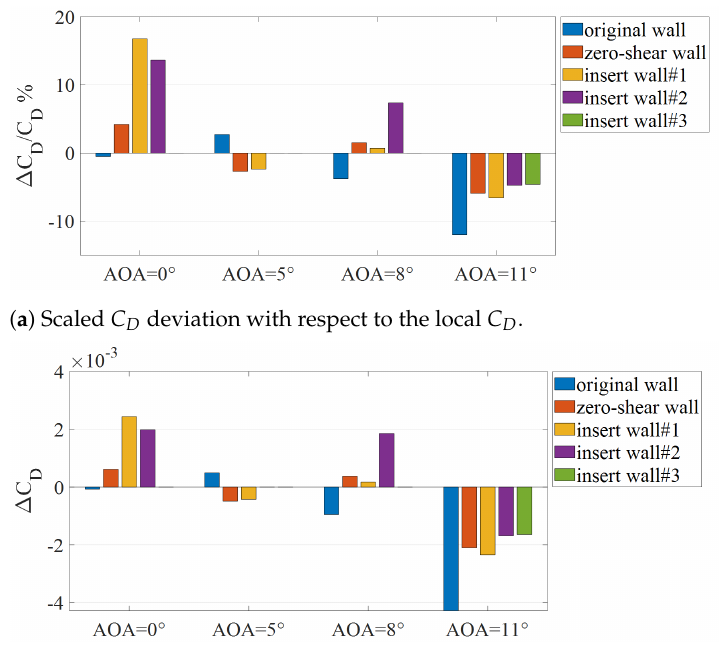
Figure 14. Relative deviation between the drag in free-flight conditions and that in the wind tunnel, using various insert